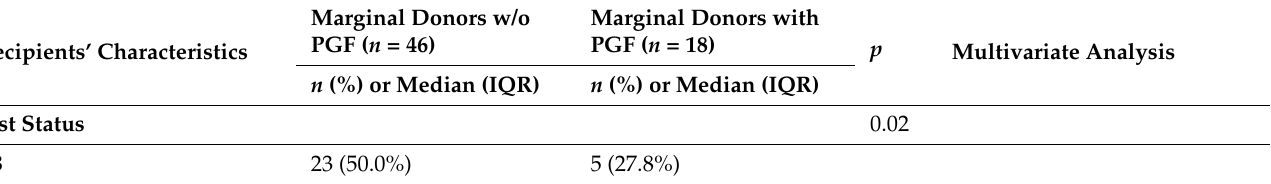
Table 5. Univariate and multivariate analysis of organ recipients from marginal donors for primary graft